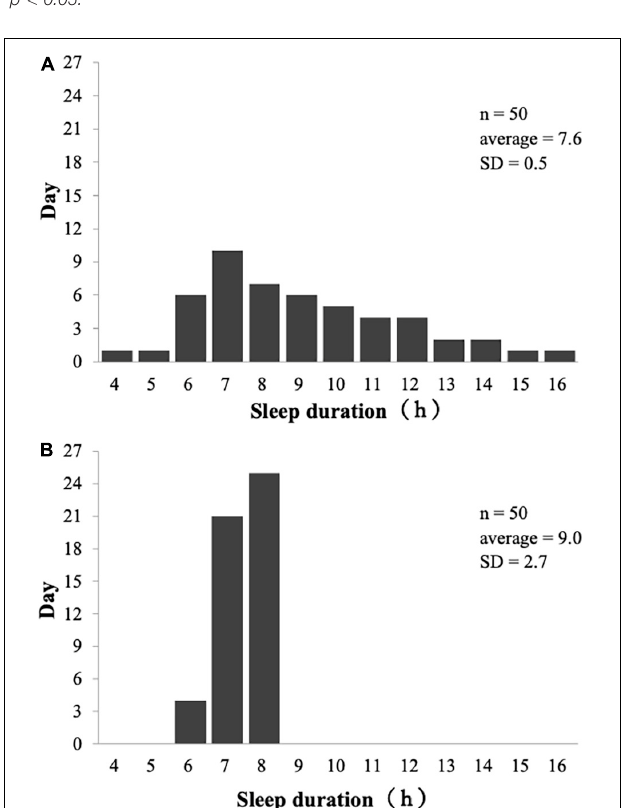
FIGURE 2 | Sleep inconsistency on typical players. (A) Example of sleep duration in large variations; (B) Example of sleep duration in small